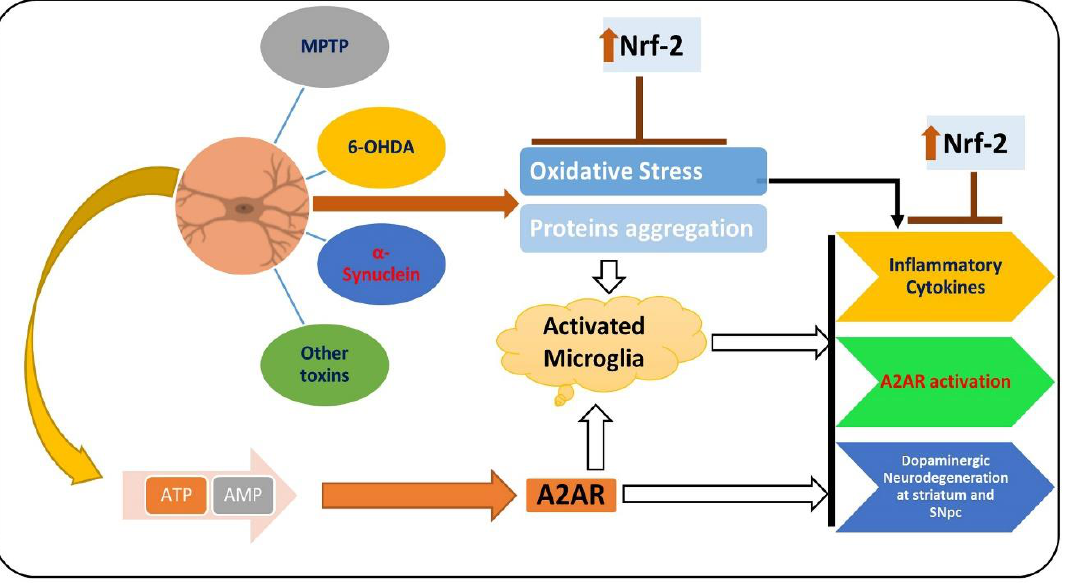
Figure 4. Role of A2A receptor and Nrf-2 in the pathophysiology of PD. MPTP, 6-OHDA, α-synuclein, and other PD-inducing toxins induce oxidative stress, consequently downregulating the expression of Nrf-2 and upregulating the expression of the A2A receptor. Elevated oxidative stress and the activation of the A2A receptor trigger neuroinflammation and dopaminergic neurodegeneration. , used for inhibition, the pointing arrow is used for the induction.